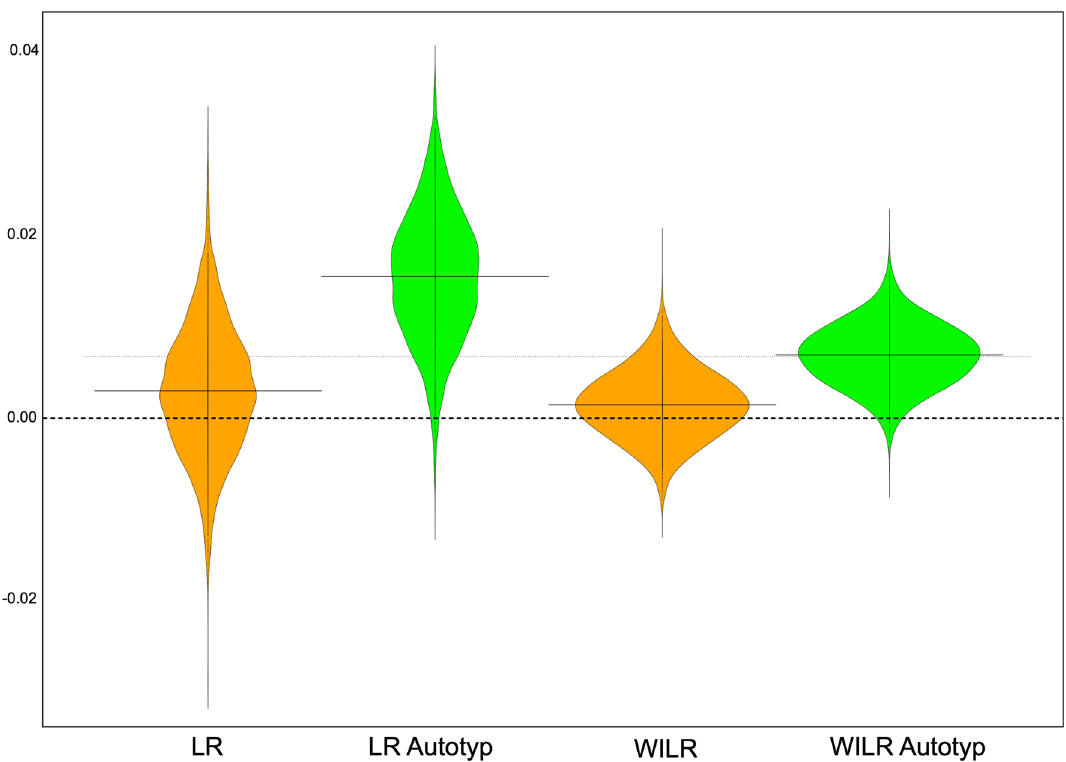
Figure 3. Beanplots for phylogenetically and geographically controlled contrasts between LR and WILR values using two subsistence databases. Each beanplot represents 5000 randomly sampled contrasts, as described in the text. Positive values represent cases in which the values were greater for non-HG